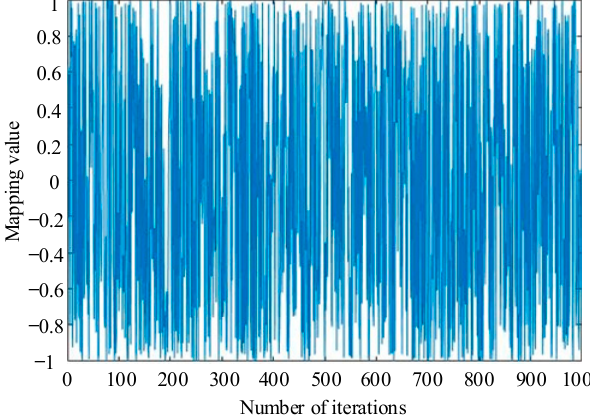
Figure 5. Chebyshev mapping distribution.